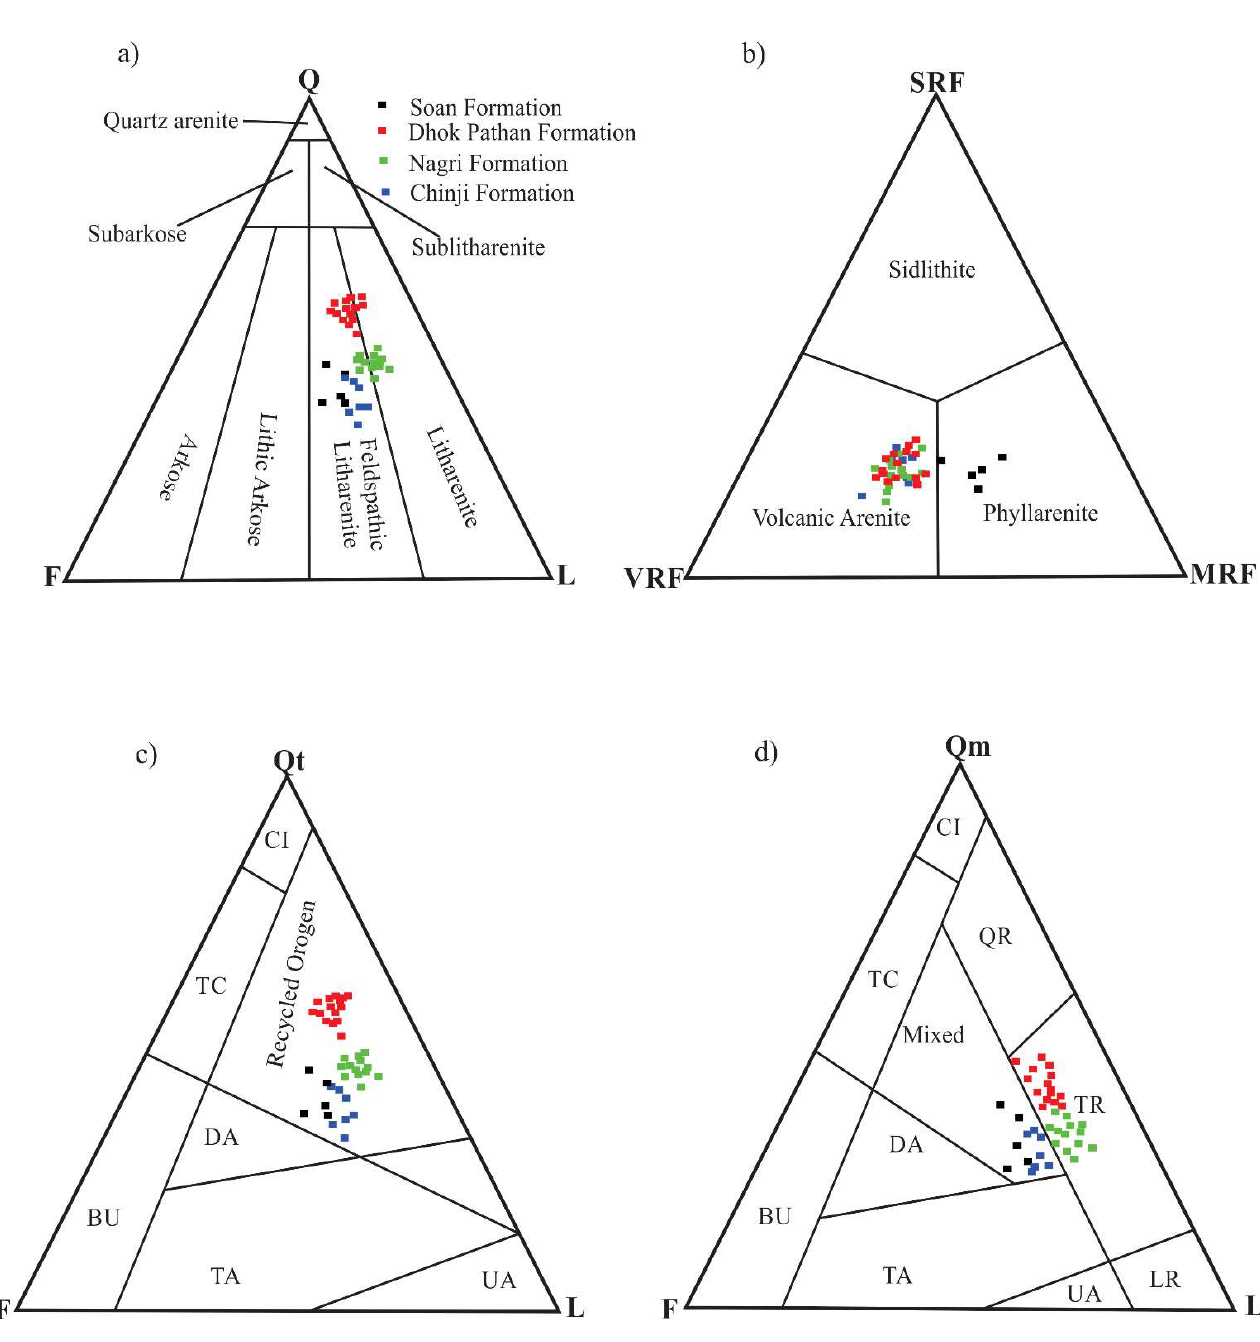
Figure 6. Mineralogical classification ( a , b ) of the sandstones of the Siwalik Group on the Folk [51] diagram and ( c , d ) show the standard triangular plots (QtFL and QmFLt) for provenance interpretation of sandstone samples of Siwalik Group (CI = craton interior; TC = transitional continent; BU = basement uplift; DA = dissected arc; TA = transitional arc; UA = undissected arc; QR = quartzose recycling; TR = transitional recycling; LR = lithic recycling).